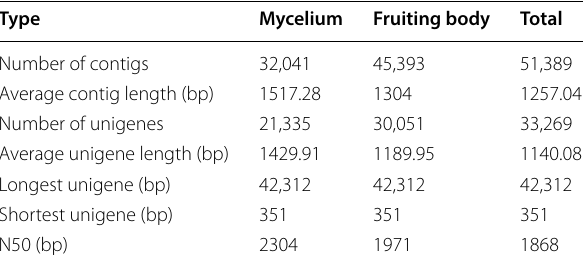
Table 2 Results of the de novo transcriptome assembly of M.